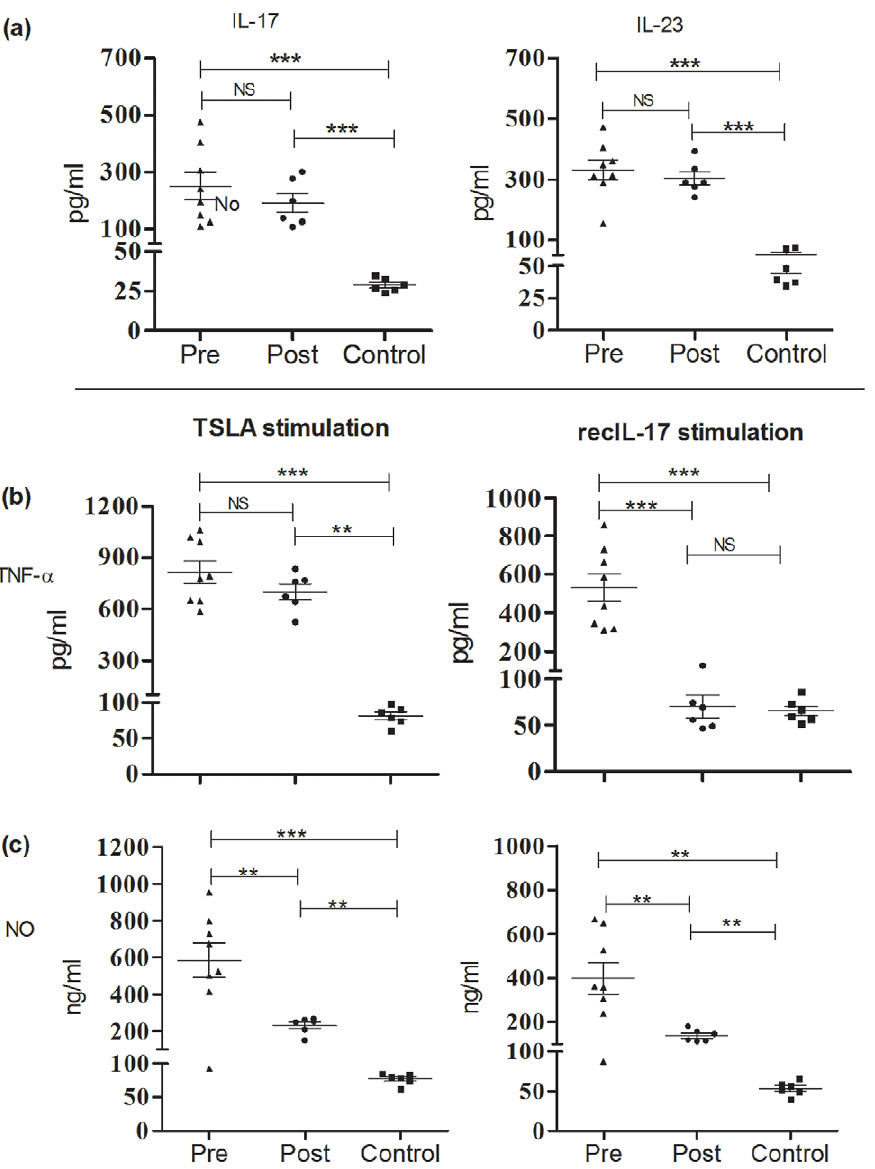
Figure 5. Levels of cytokine nitric oxide and in PBMCs supernatants stimulated with TSLA or recIL-17. (a) IL-17 and IL-23 levels in PBMCs of PKDL pre (n=8), post (n=6) and control subjects (n=6) stimulated with total soluble Leishmania antigen (TSLA). (b) Release of TNF- a (pg/ml) or (c) NO (ng/ml) from PBMCs of same set of subjects following incubation with TSLA (10 m g/ml) or recombinant IL-17 (50 ng/ml) for 72 h at 37 u C. Cytokine levels were determined by ELISA and NO was quantified by Griess reagent method in culture supernatants. The concentrations shown are the values in the stimulated cultures minus the unstimulated controls. Individual values (pg/ml) are presented and the mean 6 SE are shown. **P , 0.01, and ***P ,